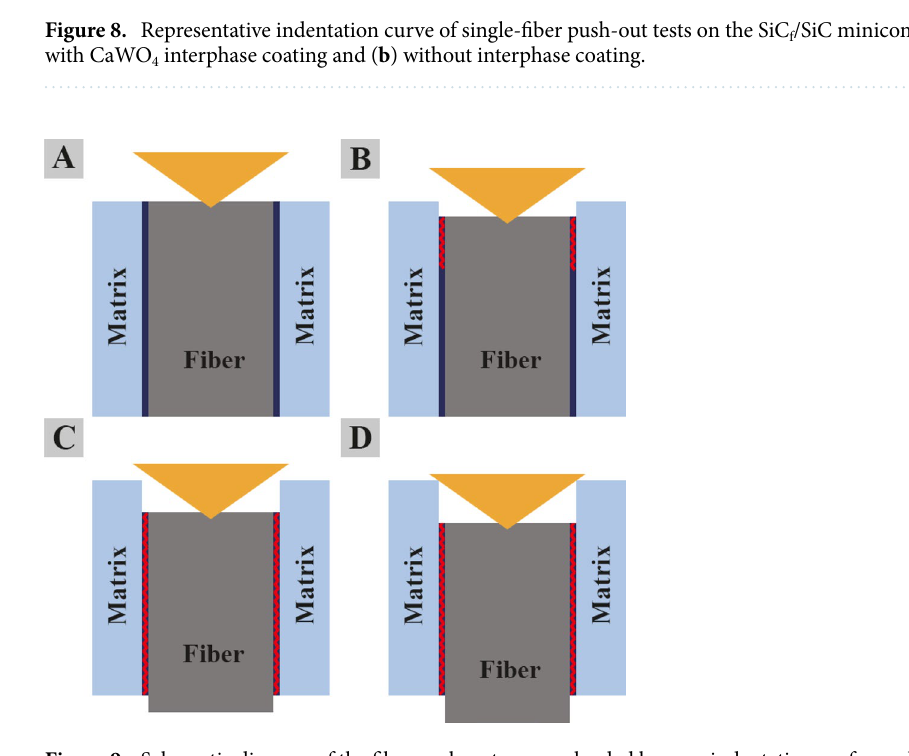
Figure 9. Schematic diagram of the fiber push-out process loaded by nanoindentation performed on the SiC f / CaWO 4 /SiC minicomposite. Adapted from reference 25